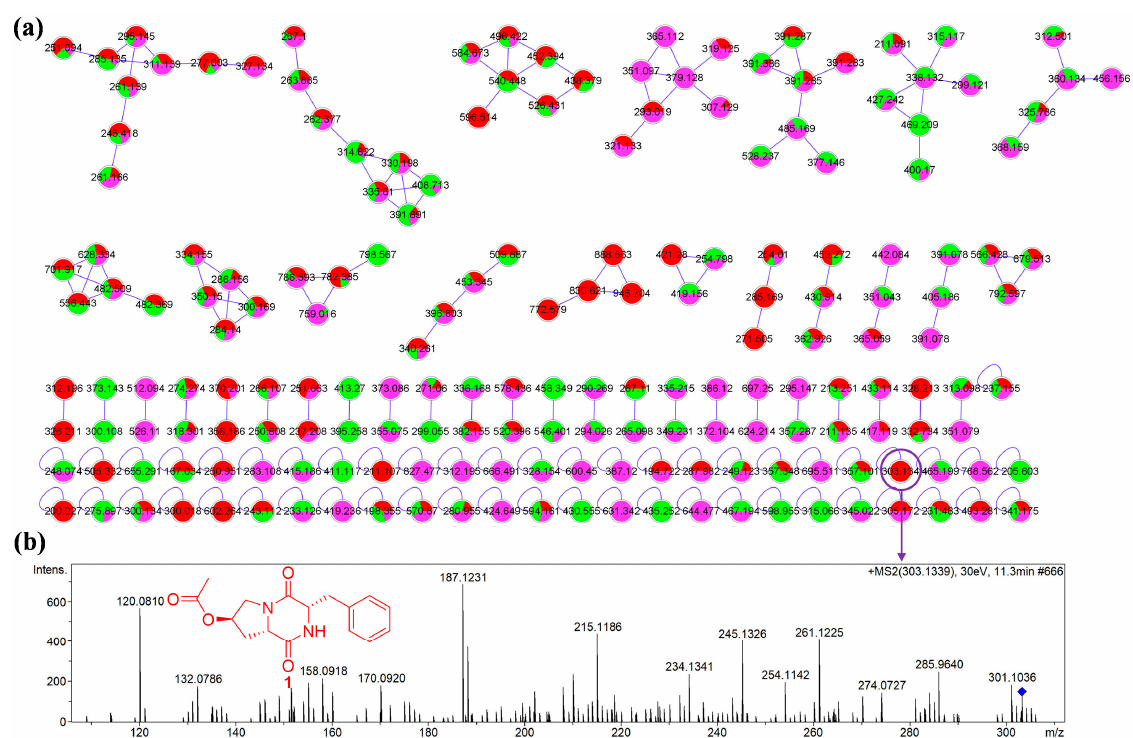
Figure 2. The molecular networking from SCSIO 52865. ( a ) Partial cluster-node graph of molecular networking from three media, in which red, green and pink nodes represented ion peaks from EtOAc extracts of mBHI, mA and mISP2, respectively. The label reparented for parent mass. ( b ) The annotation of a node of parent ion at m / z 303.134 (the small blue quadrilateral) from molecular networking was corresponding to the chemical structure of compound 1 .